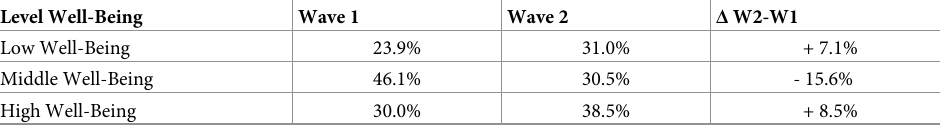
Table 5. Estimated longitudinal probabilities of the three well-being levels by latent transition analysis.